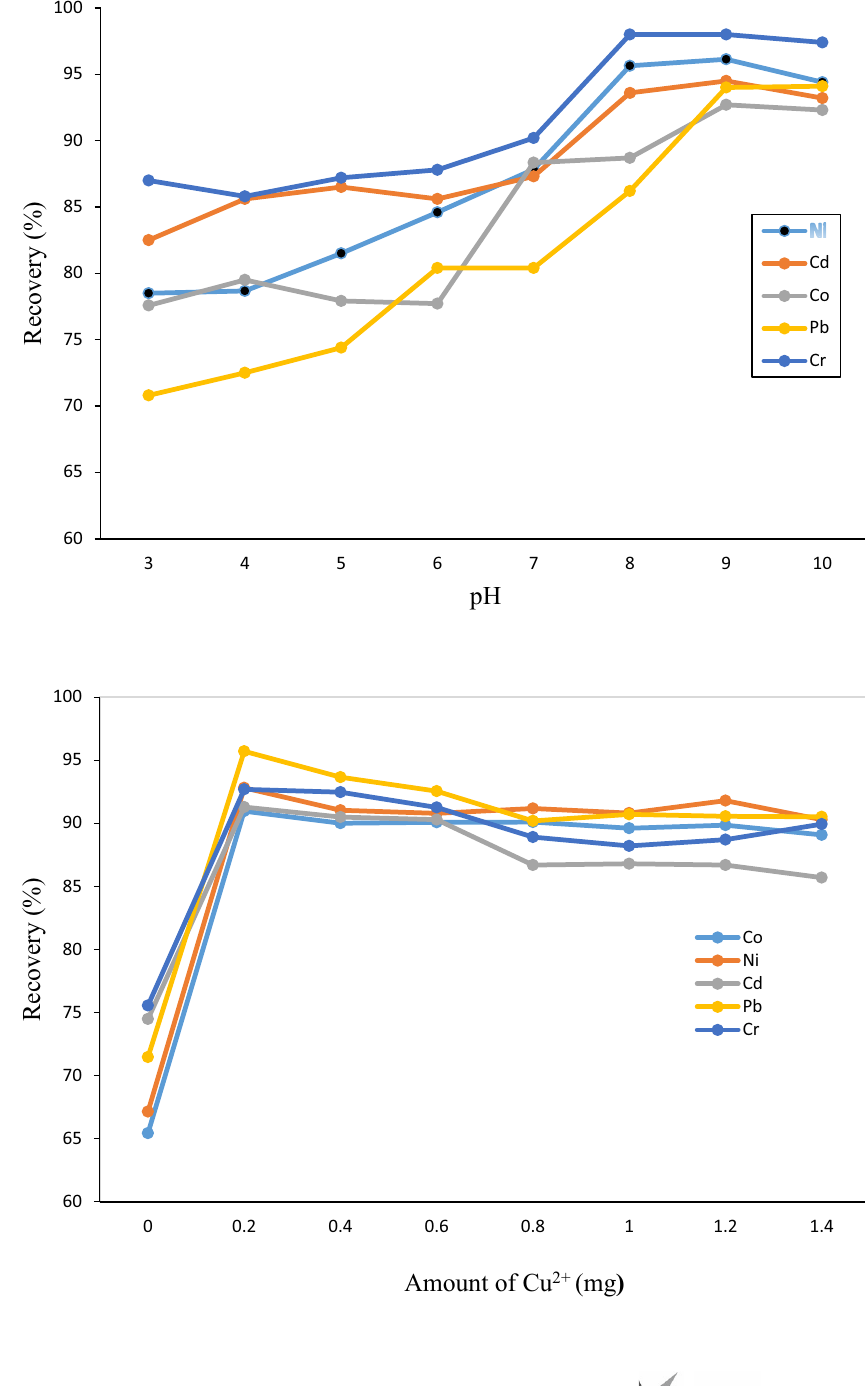
Fig. 2 Effect of pH on the recovery of heavy metals in the model solutions